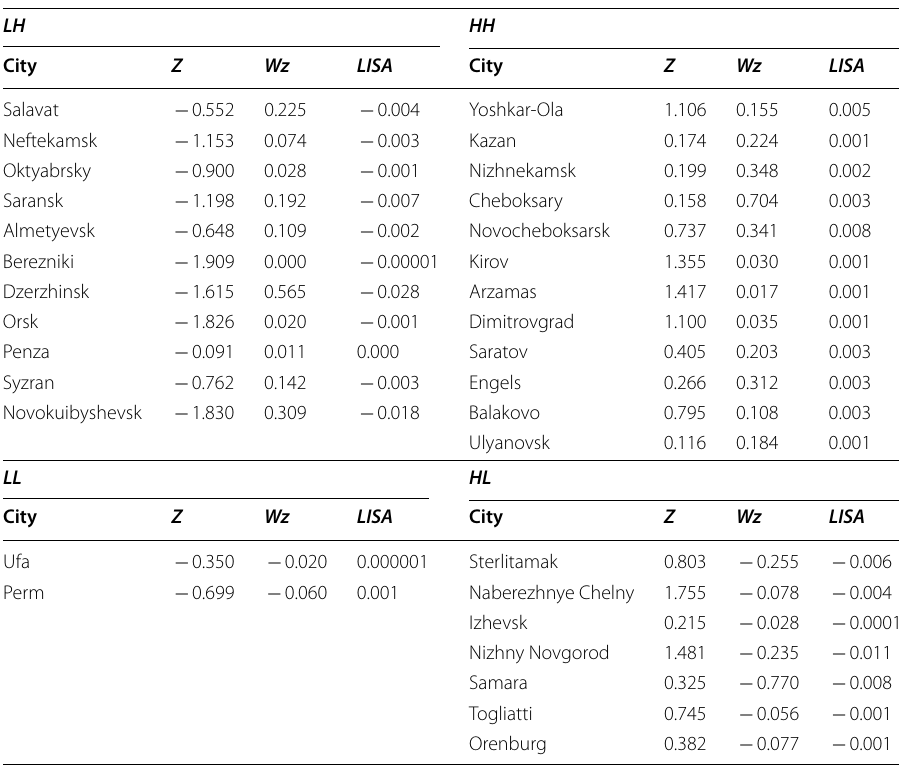
Table 3 Grouping of cities of the Volga Federal District of Russia by the Moran’s index (population density) in 2017 (Russian regions. Main social and economic parameters of cities. 2018 // Federal Service of State Statistics [Electronic resource] URL:http:// www. gks. ru/ free_ doc/ doc_ 2018/ region/ reg- gor18. pdf (date of application